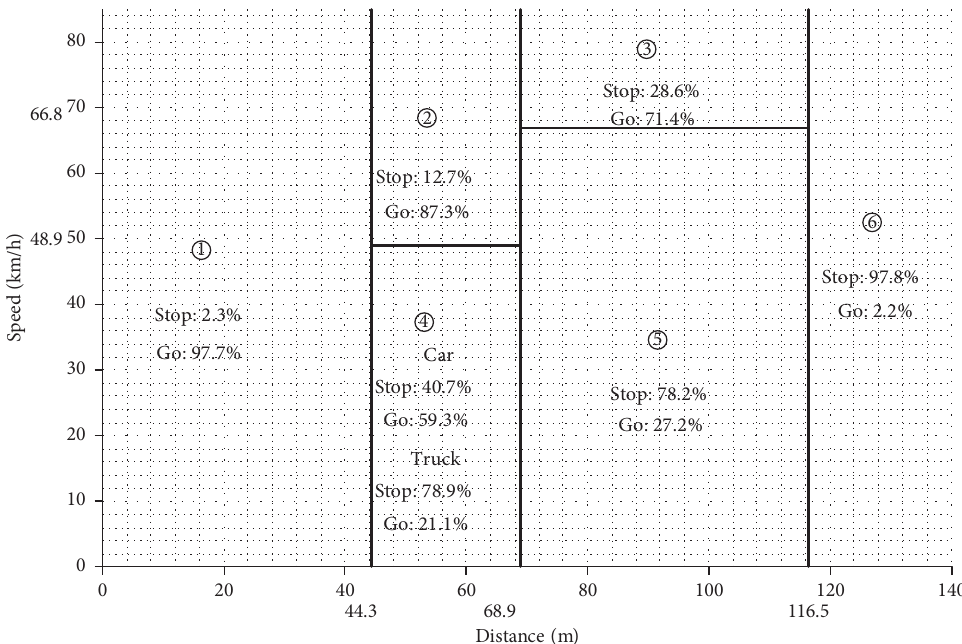
Figure 5: Partition for the stop/go decision model for rural high-speed